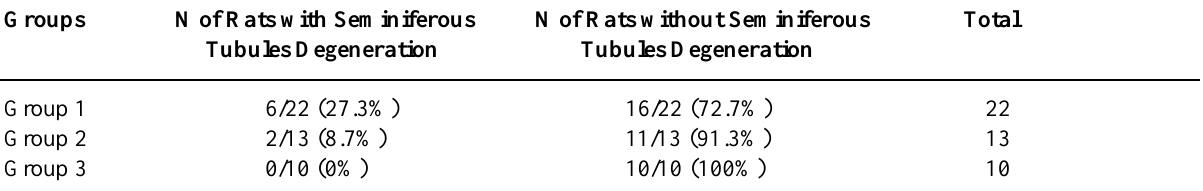
Table 1 – Frequency of rats with cirrhosis, with and without food restriction, presenting cross-sections of degenerated seminiferous tubules.